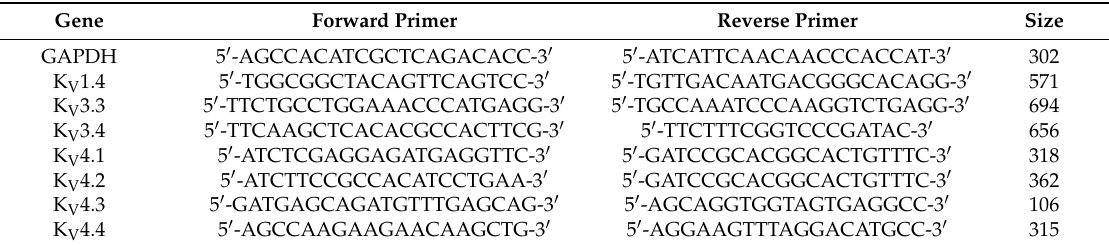
Table 2. Primers of transient outward potassium channels used for